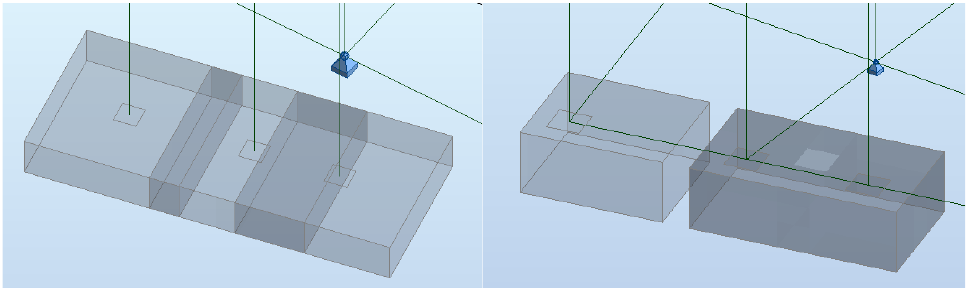
Figure 10. Geometric overlap of the footings and the adopted solution.